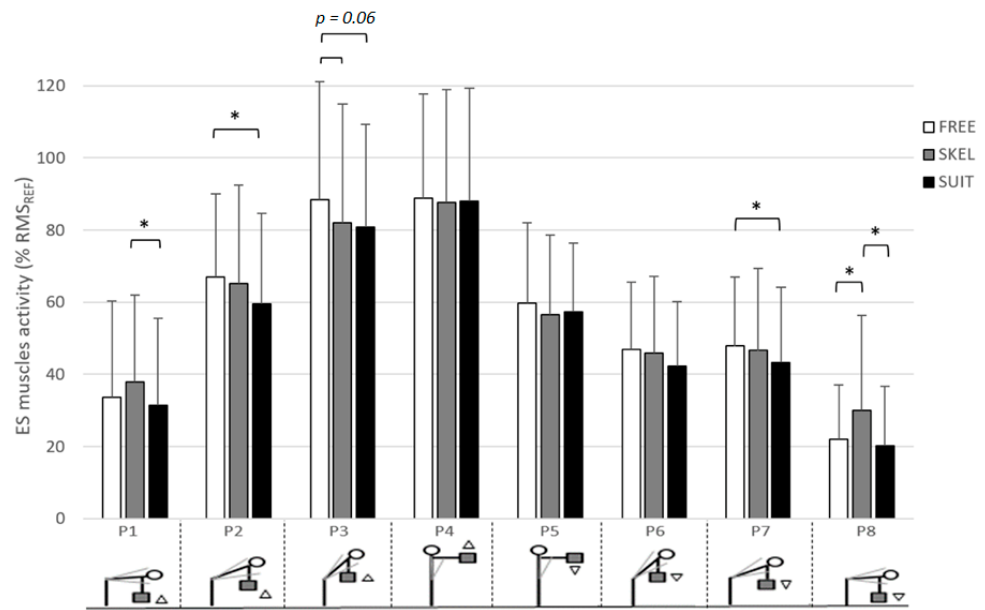
Figure 5. Averaged ES muscle activity (% RMS REF ) and standard deviation for each TSI part (from P1 to P8) with the rigid exoskeleton (SKEL, gray), the exosuit (SUIT, black), and without equipment (FREE, white). *: significant differences between exoskeletons ( p < 0.05).